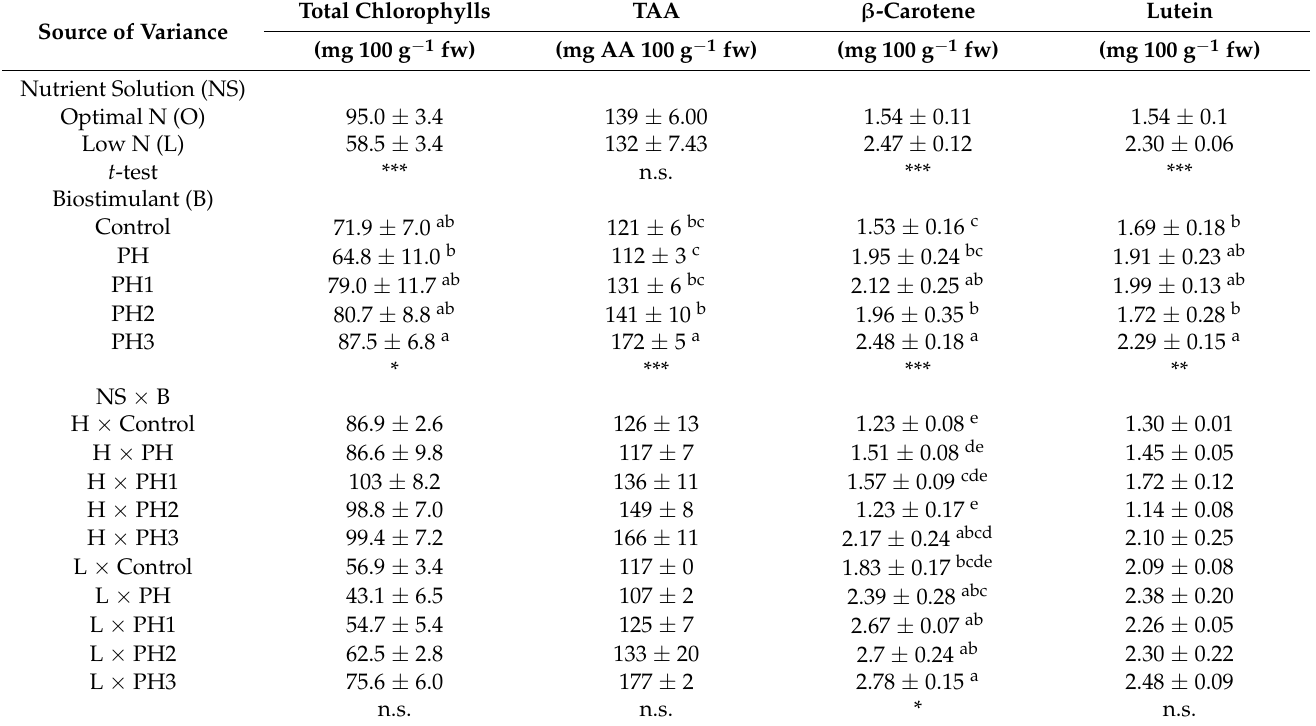
Table 2. Chlorophyll, auxiliary pigments, total ascorbic acid content of lettuce plants as affected by nitrogen dosage and biostimulant